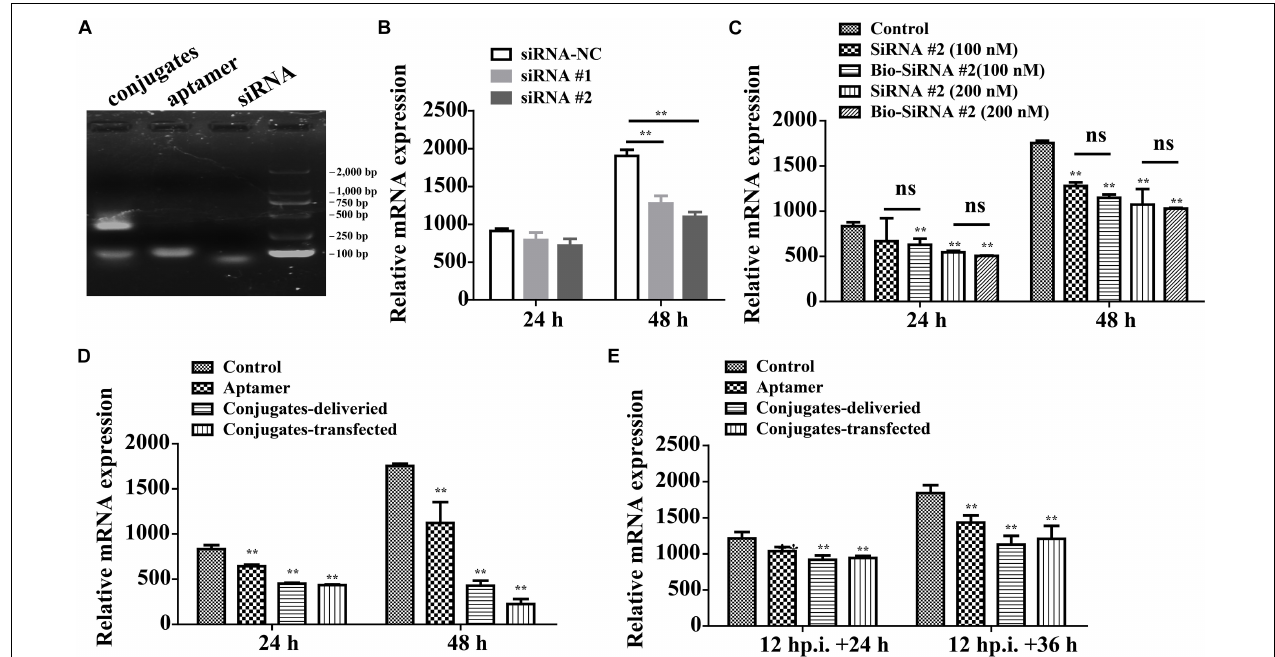
FIGURE 7 | Aptamer conjugate for the delivery of functional siRNA. (A) Gel-shift analysis confirmed the conjugation of the Bio-aptamer and Bio-siRNA to streptavidin. (B) Gene silencing efficiency of siRNA for CP. (C) The biotin label did not significantly affect the silencing efficiency. (D) Inhibition of RGNNV infection by aptamer–siRNA conjugate. Compared with the control cells incubated with RGNNV alone, the relative CP mRNA expression decreased by 36.0% at 48 hp.i. in the cells exposed to mixtures of RGNNV and aptamer (100 nM) and by 75% in the cells exposed to mixtures of RGNNV and the aptamer–siRNA conjugates (50 nM). The efficiency of the delivery system (75% reduction in CP mRNA expression at 48 hp.i.) was slightly inferior to that of a transfection system, which reduced CP mRNA expression by 87.2% at 48 hp.i. (E) The conjugates showed relatively less antiviral effect against RGNNV-infected cells (24 hp.i.). (** P < 0.01; * P <